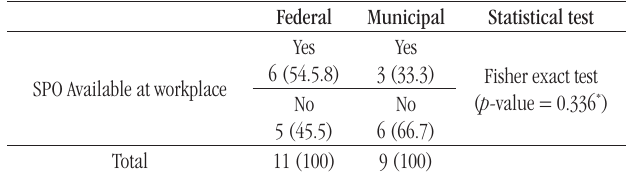
taBLE 6 − SPO availability at the workplace in municipal and federal public hospital CLA Federal Municipal Statistical test SPO Available at